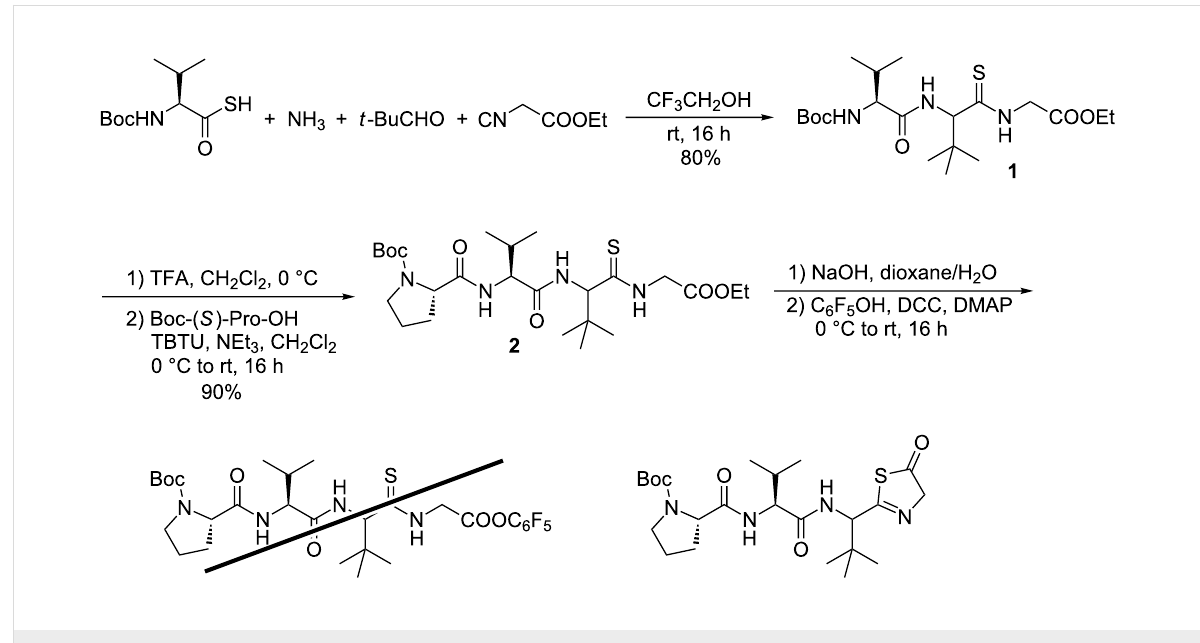
Scheme 1: Syntheses of endothiopeptides by thio-Ugi reaction.